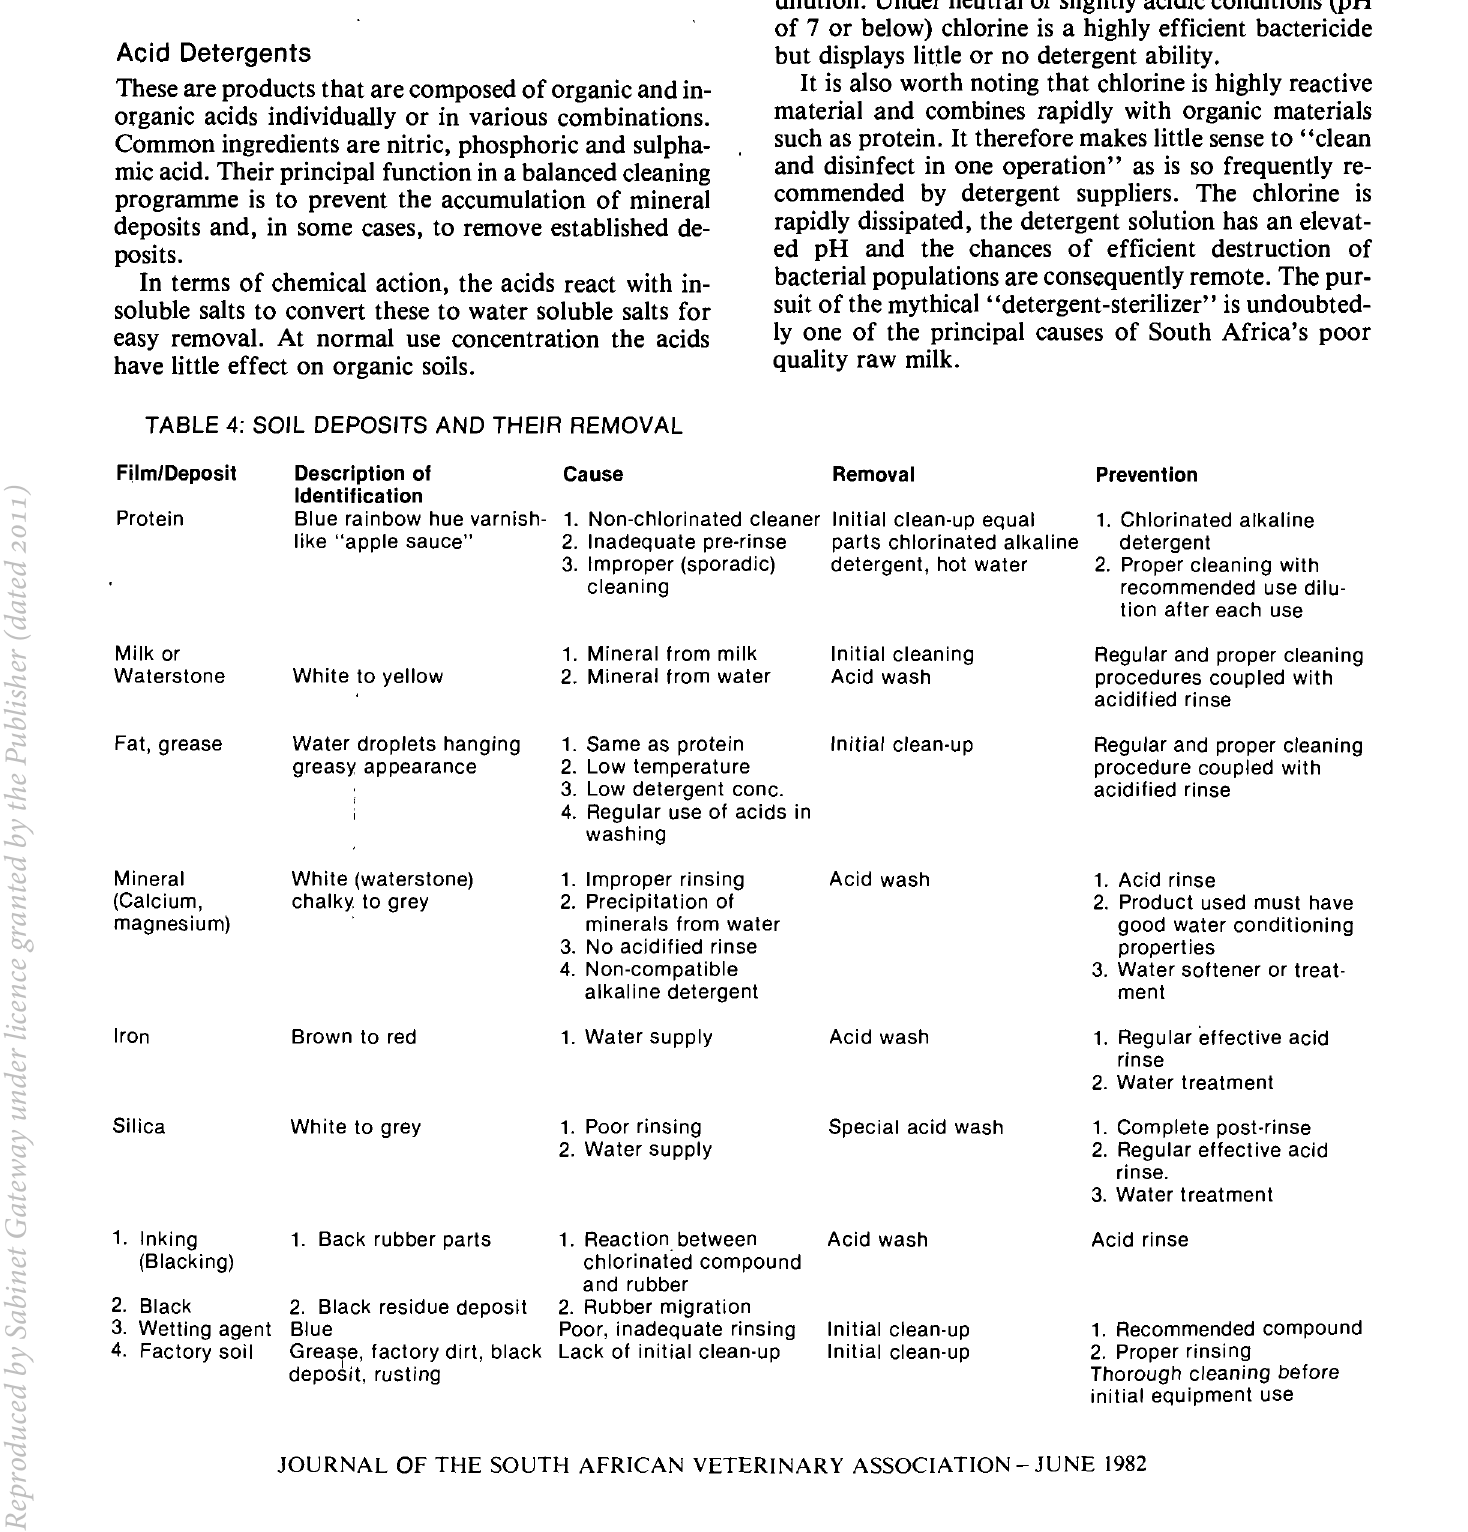
TABLE 4: SOIL DEPOSITS AND THEIR REMOVAL